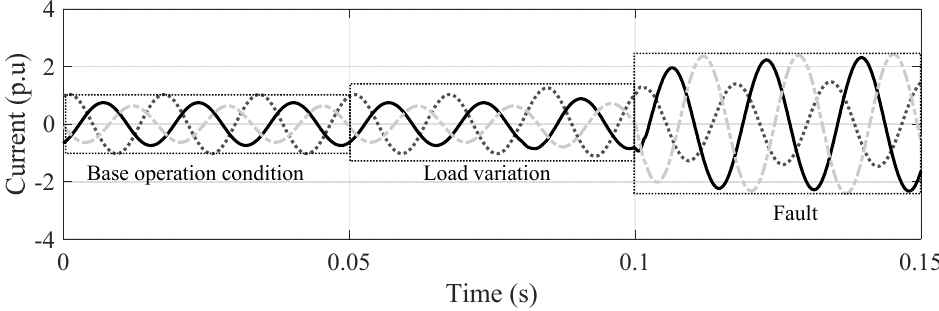
Figure 4. Generation of non-fault and faulted events in a current signal.